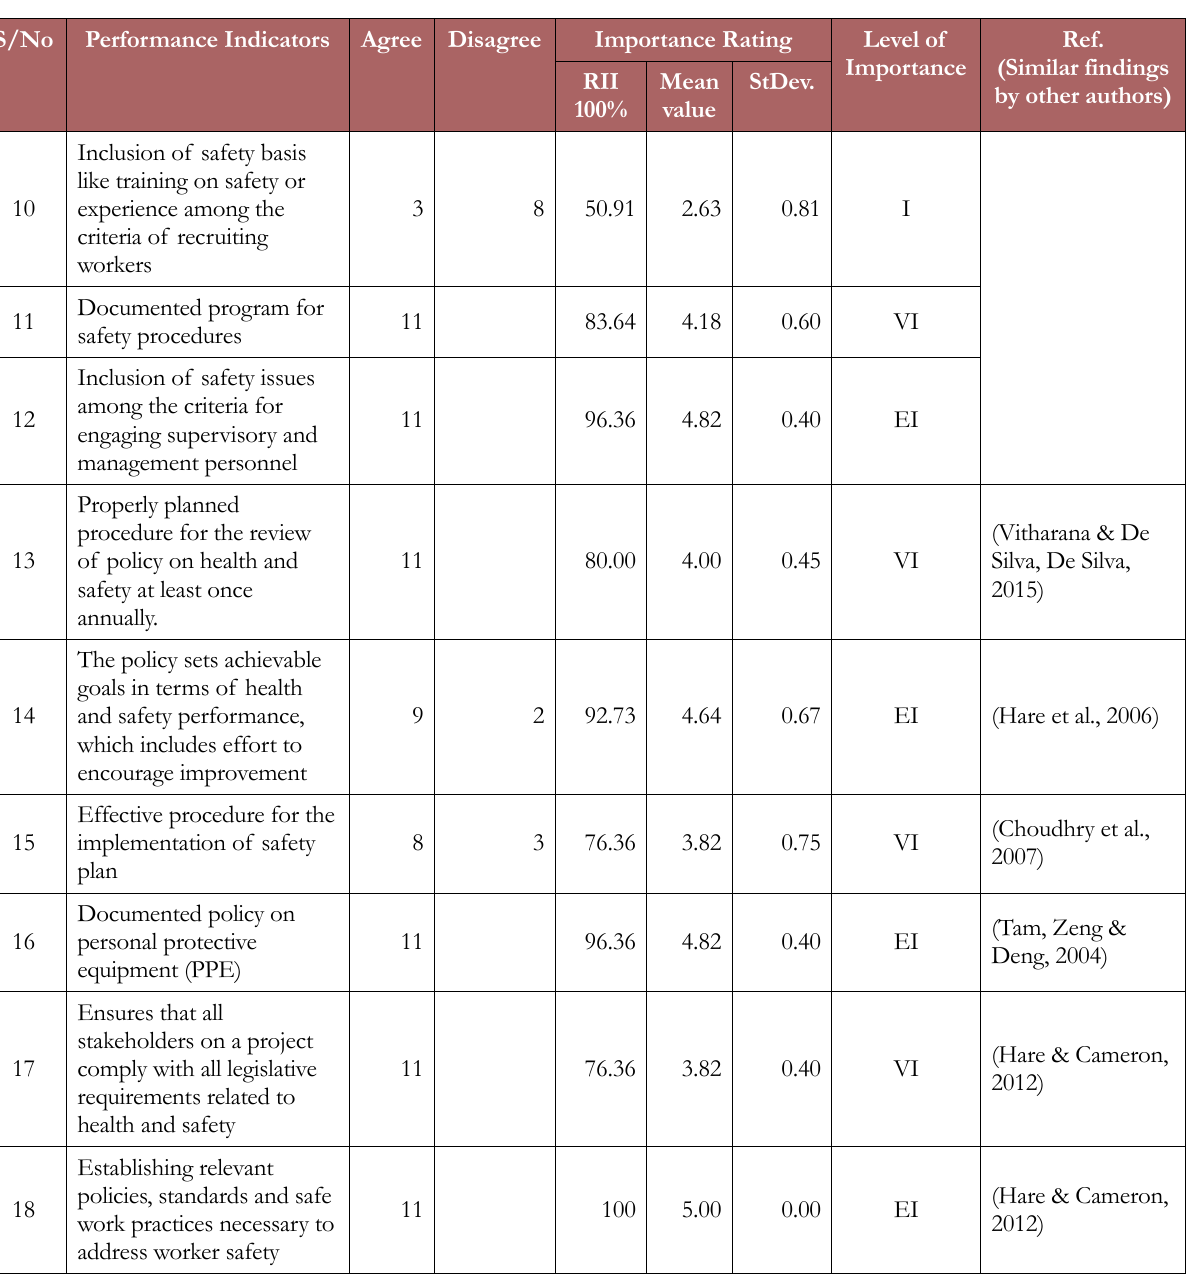
Table 4. Key Performance Indicators for construction safety